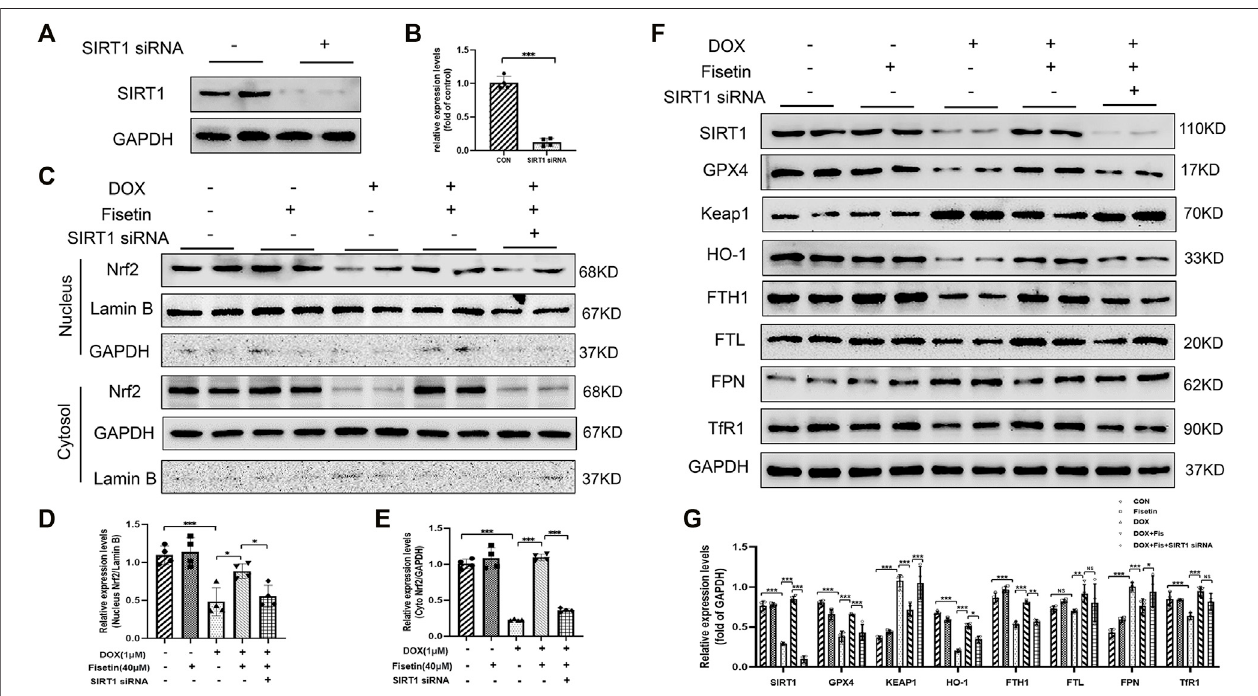
FIGURE7| FisetinalleviatesDOX-induced ferroptosis via theSIRT1/Nrf2-regulated signalingpathway. (Aand B) .WesternblotresultsofSIRT1protein levelsafter SIRT1siRNAtransfection. (C) .WesternblotofnuclearandcytosolNrf2levels invitro aftertreatmentwithDOXand/or fi setin,SIRT1siRNA. (D – E) nucleusorcytosolNrf2 protein from Western blot results. (F) .Proteinexpression levels ofSIRT1,GPX4, Keap1, HO-1, FTH1, FTL,FPN, TfR1, and nuclear Nrf2 inH9c2 cells administrated with DOXand/or fi setin,SIRT1siRNA. (G) .Quanti fi cationofSIRT1,GPX4,Keap1,HO-1,FTH1,FTL,FPN,andTfR1proteinfromWesternblotresults( n =4).Thevalues are presented as mean ± SD. * p < 0.05; ** p < 0.01; *** p < 0.001; NS, no signi fi